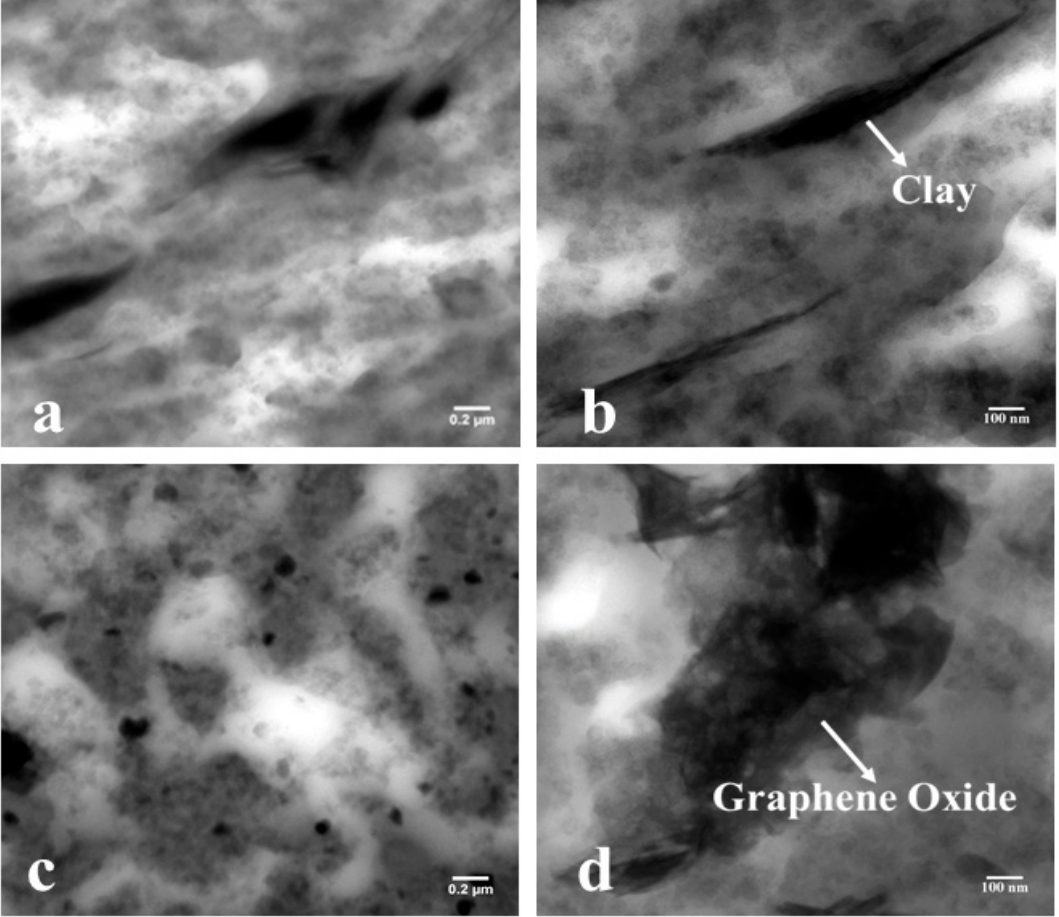
Figure 5. TEM images of ( a , b ) nanoclay in chlorobutyl rubber (CIIR)/natural rubber (NR) and ( c , d ) graphene oxide in CIIR/NR. Table 3. Cure characteristics of polymer nanocomposites. Sl